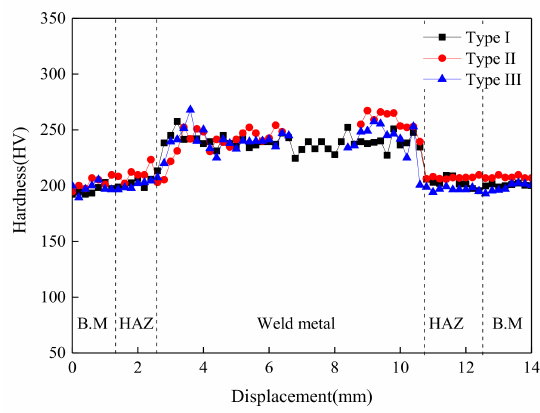
Figure 9. Measured hardness profiles of weld according to specimen types.